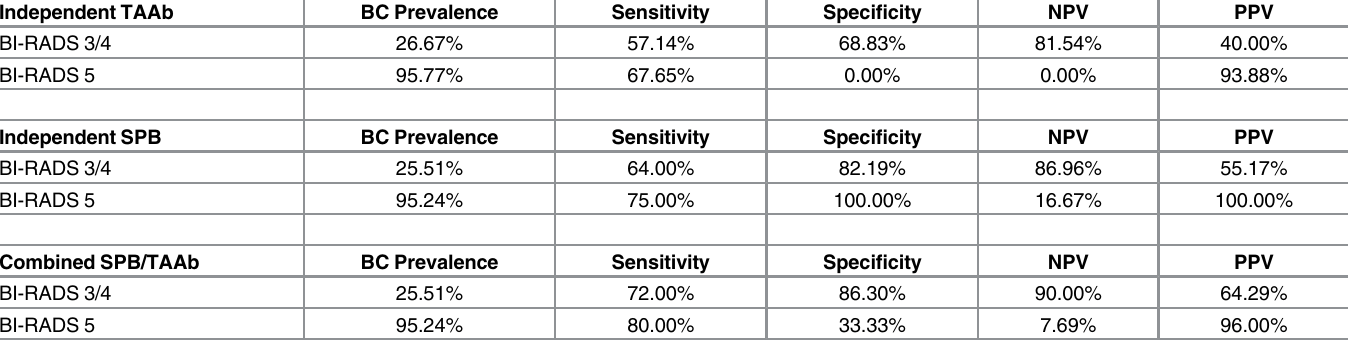
Table 4. Summary of Model Performance based on subject BI-RADS. Model performance is shown for subjects categorized as BI-RADS 3 or 4 and BI-RADS 5. BC prevalence is shown to indicate the number of subjects diagnosed with breast cancer as a percentage of the total for each BI-RADS popula- tion. Some samples that were excluded from SPB and Combined model building due to incomplete SPB